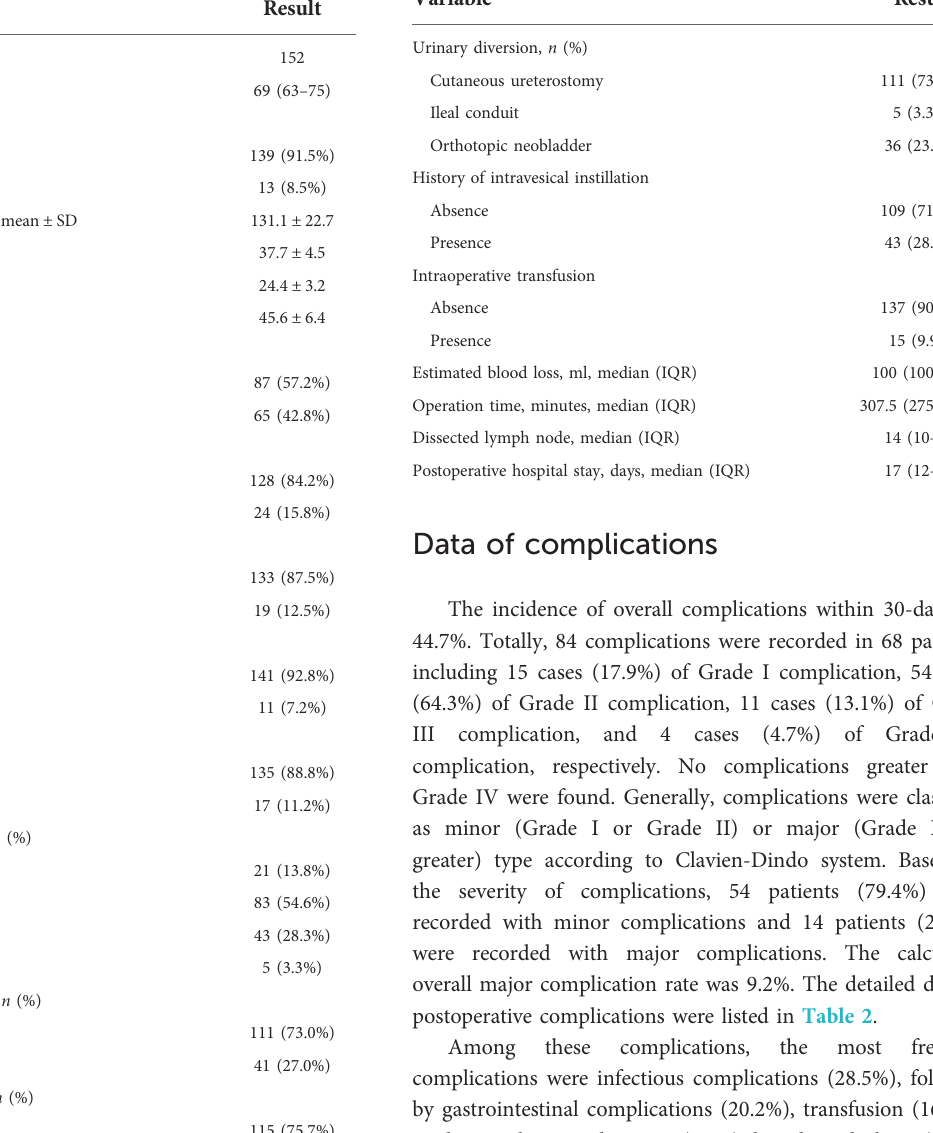
TABLE 1 Baseline characteristics and perioperative data of included